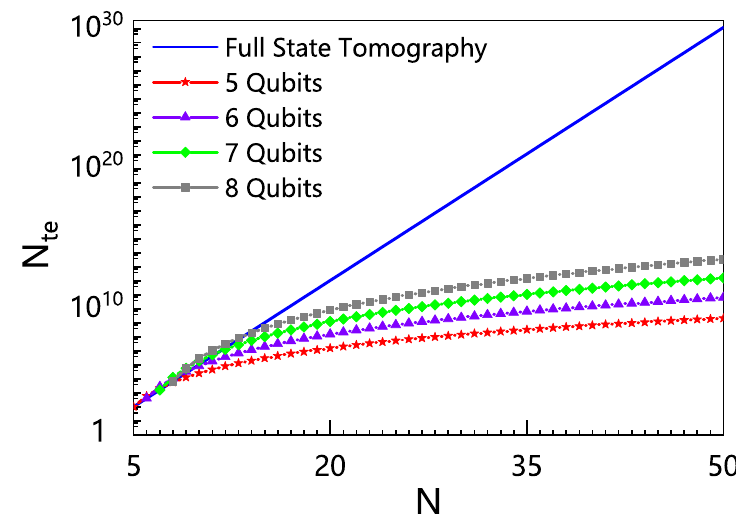
Figure A5. Comparison among the number of elements used in different methods, including full state tomography and the Bell–Shor algorithm on k qubits ( k = 5,6,7,8 ) .